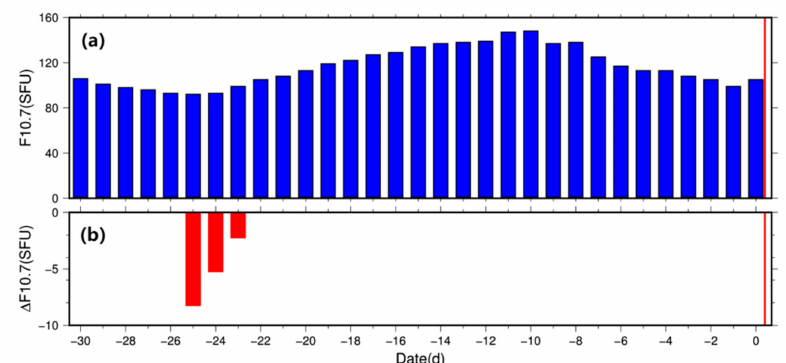
Figure 3. F10.7 index variations for one month preceding the Lushan earthquake: ( a ) the time series of F10.7, and ( b ) the anomalies of F10.7 ( ∆ F10.7) by the interquartile range (IQR) with a 27-day sliding window.